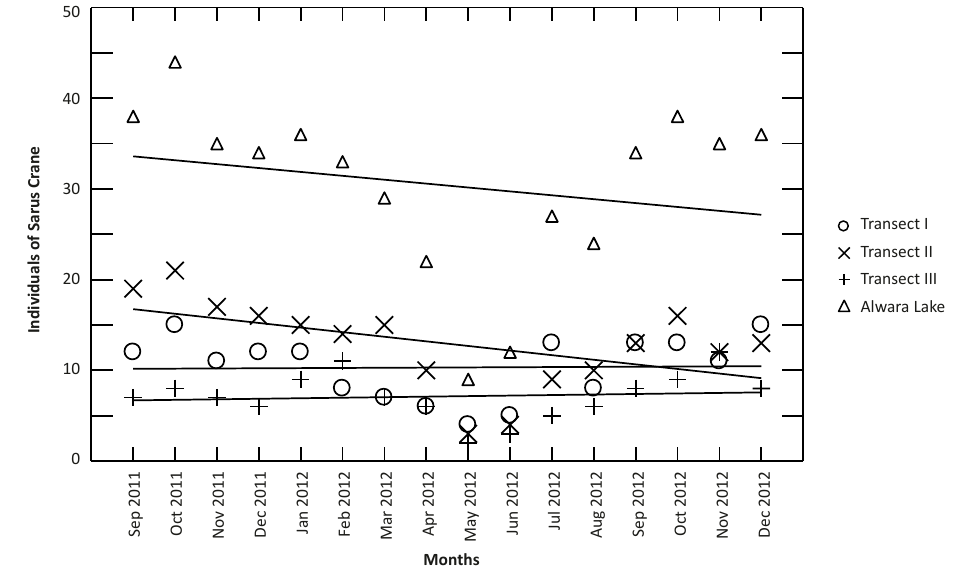
Figure 1. Scatter plot with linear line, showing the differential distribution of Sarus Crane in study area of Transect I, II,